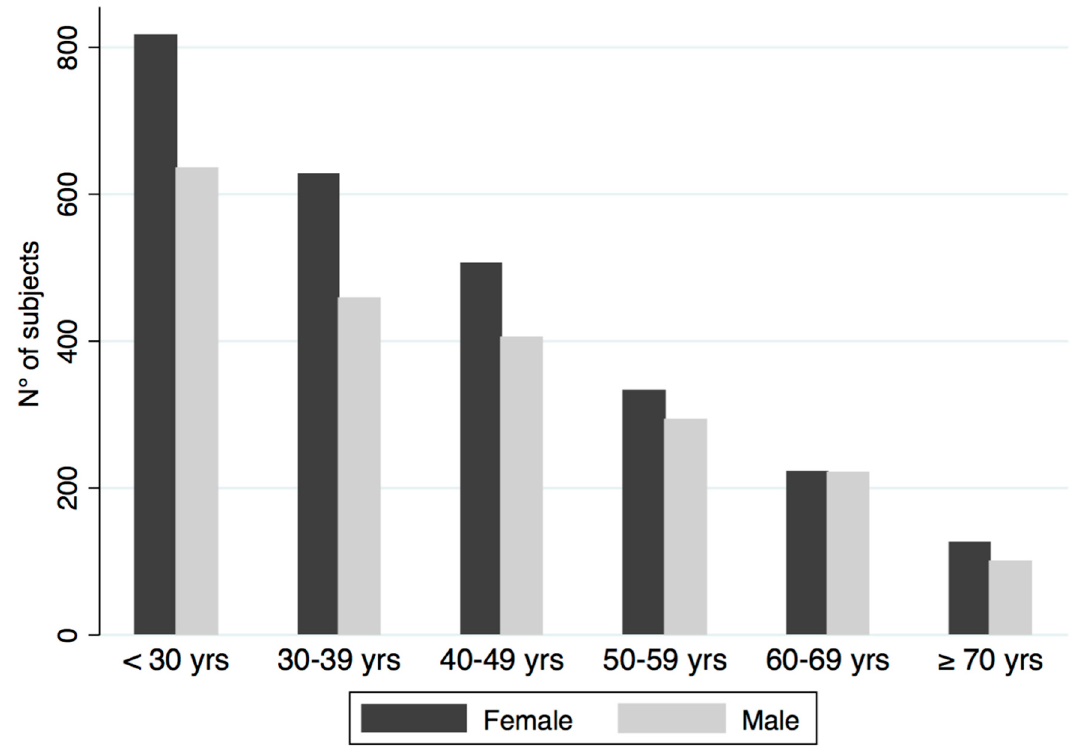
Figure 1. Age decades accordingly to gender.